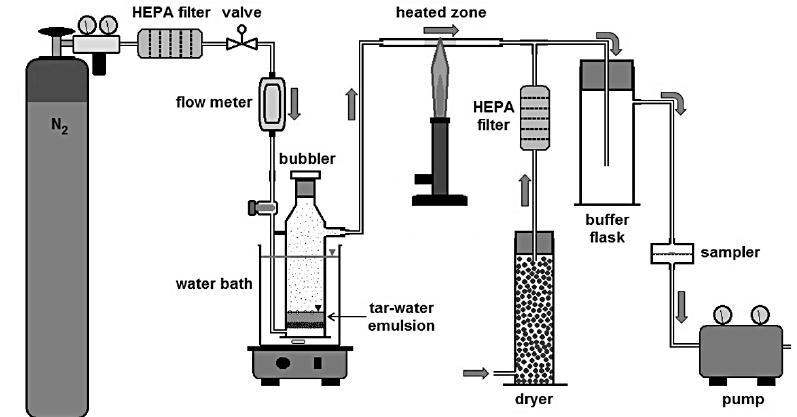
Figure 1. All-glass apparatus for generation and collection of tar-ball particles from liquid tar-water emulsions.